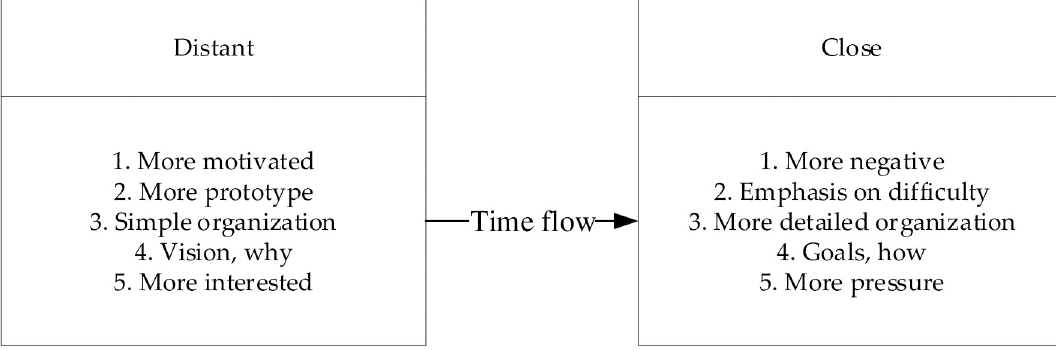
Fig 1. Changes in construal level during goal-oriented